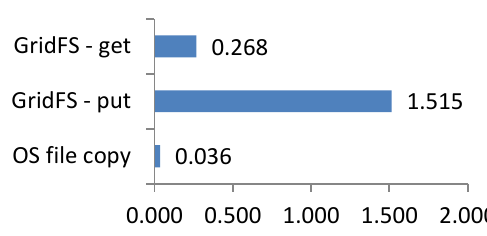
Figure 6: Transfer times for local transfer.